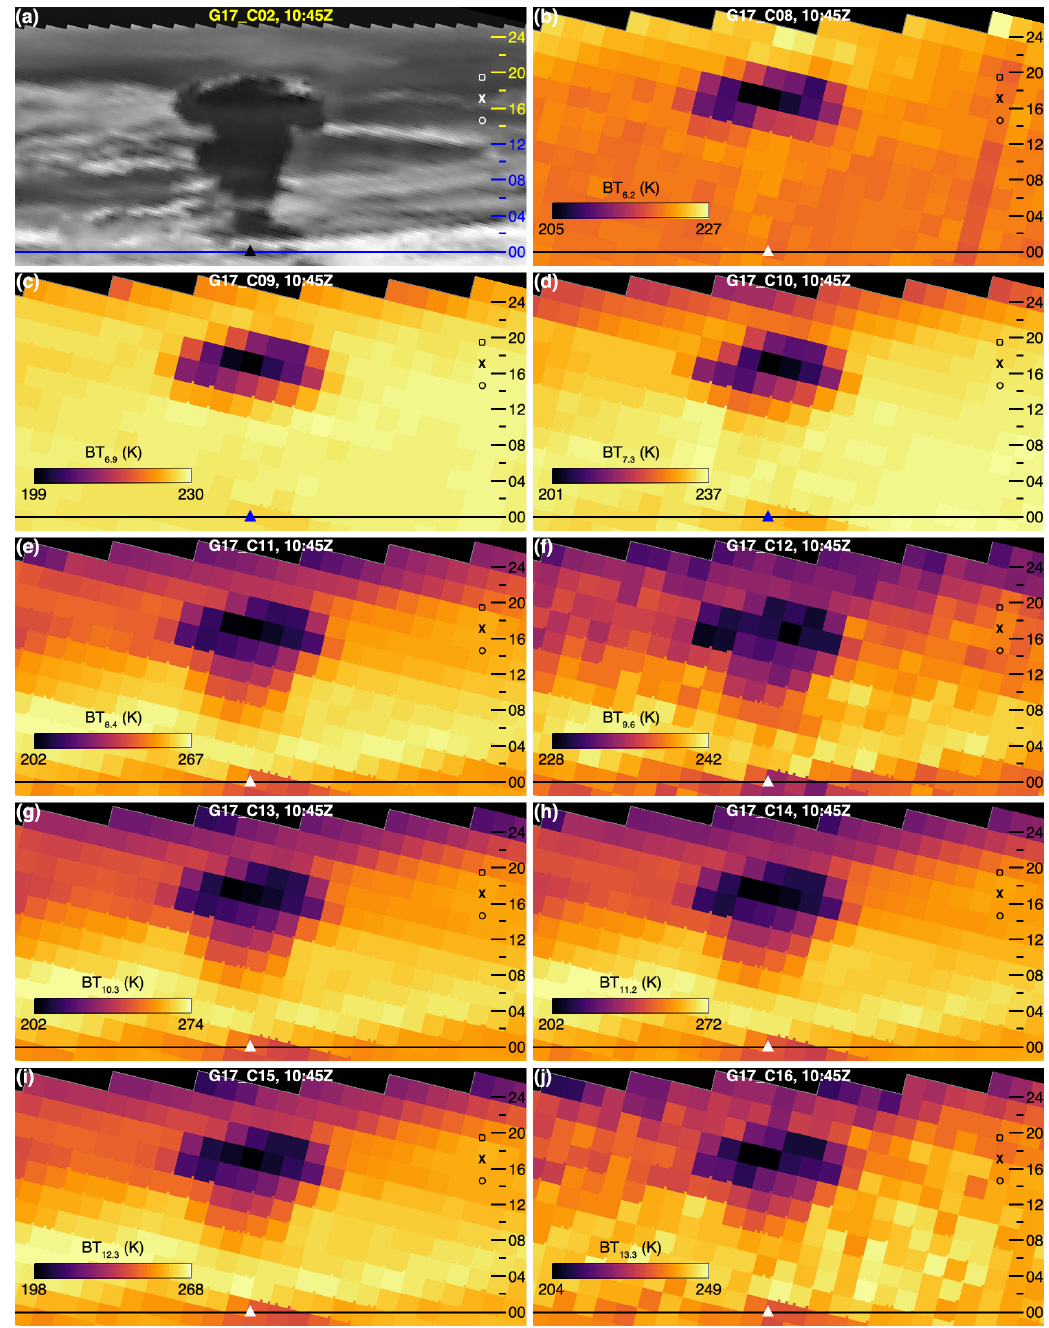
Figure 10. The eruption plume on 11 April 2021 at 10:45UTC in GOES-17 imagery: (a) the visible channel 2 and (b–j) the IR channels 8–